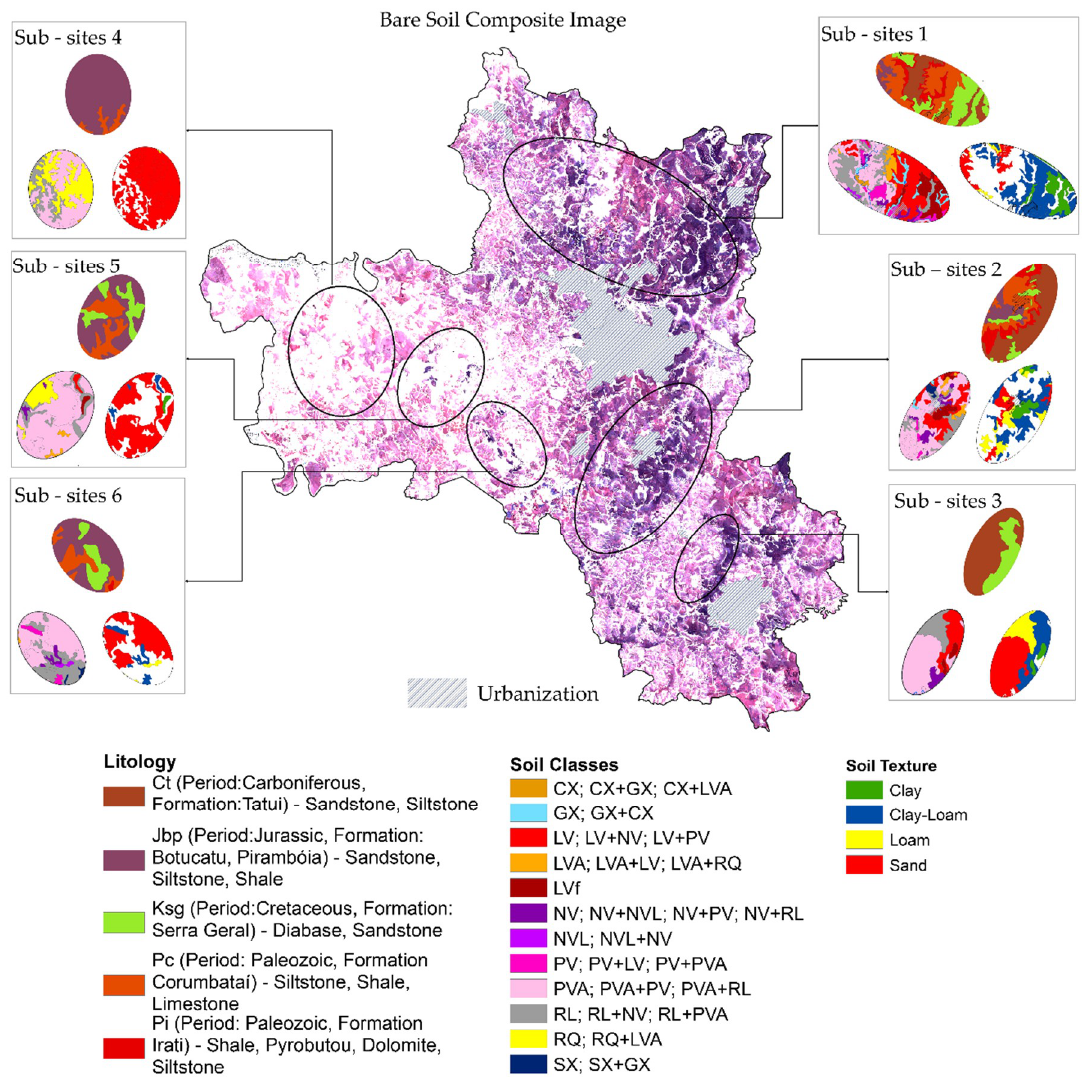
Figure 7. Bare Soil Composite Image (BSCI) with false color RGB 543 showing the variations of color according to soil properties. White pixels are not available (NA) values. The subsites indicate the relationship of BSCI with the geology classes, soil types, and soil surface texture of legacy maps.